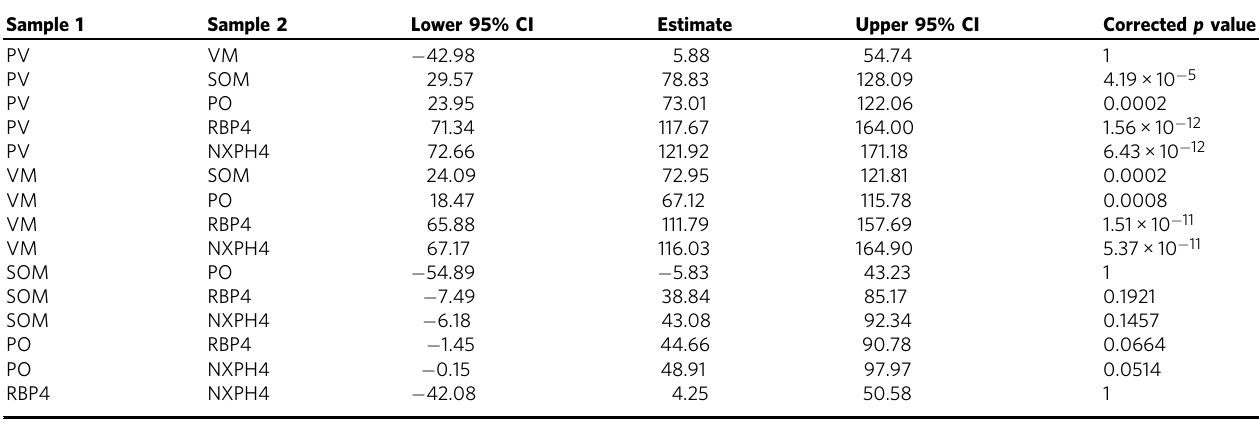
Table 2 Multiple comparison tests for myelination